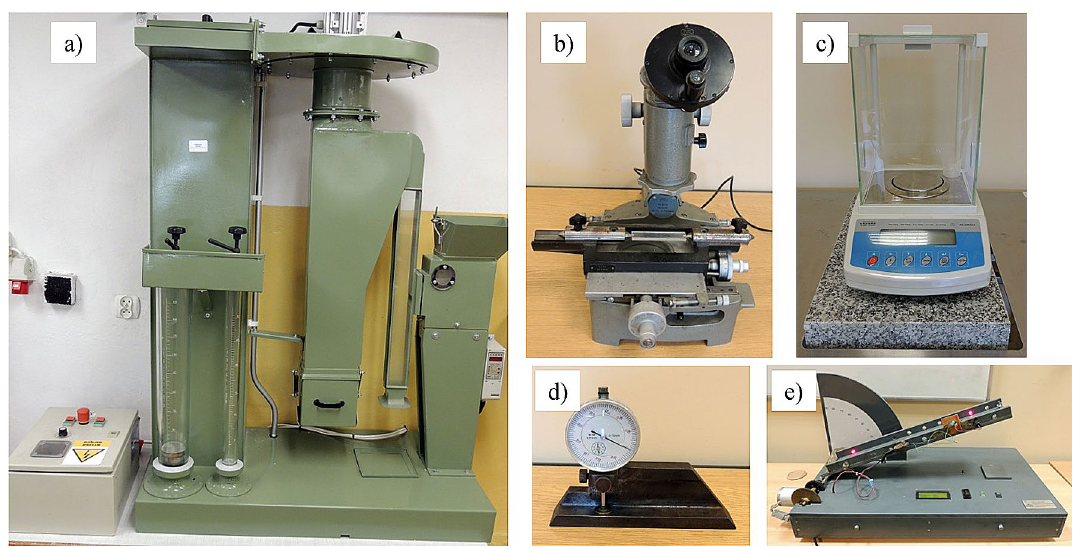
Figure 4. Laboratory installations: ( a ) Petkus K-293 air separator, ( b ) MWM 2325 workshop microscope, ( c ) WAA 100/C/2 laboratory scale, ( d ) dial thickness gauge, ( e ) friction